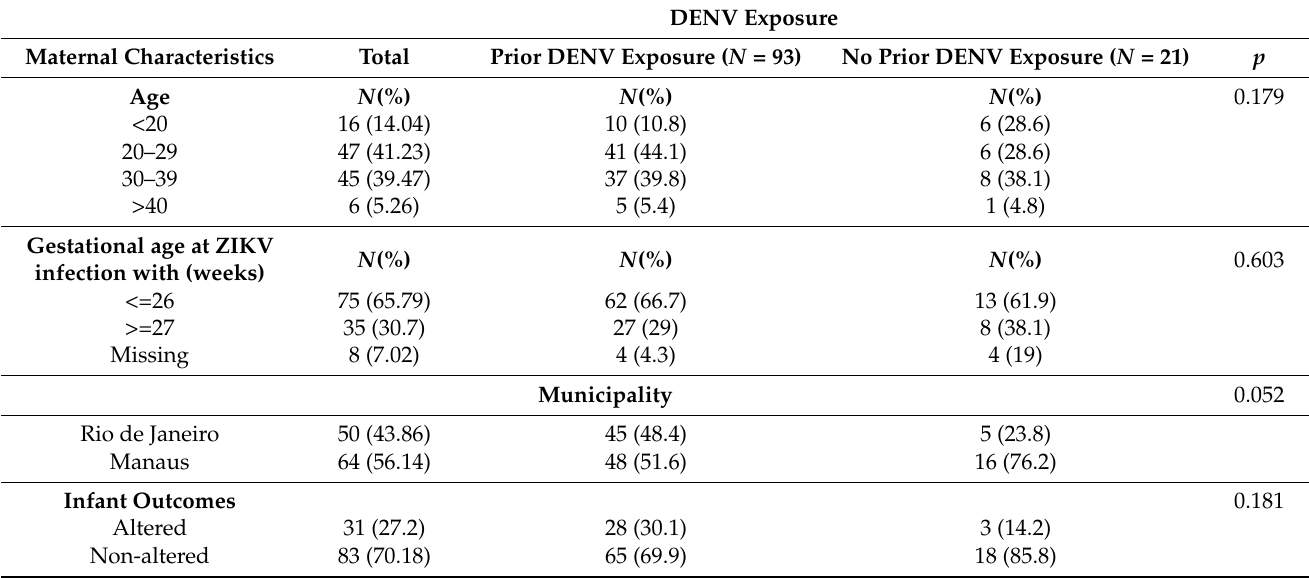
Table 2. Maternal characteristics and infant outcomes, stratified by dengue virus (DENV) exposure. DENV Exposure